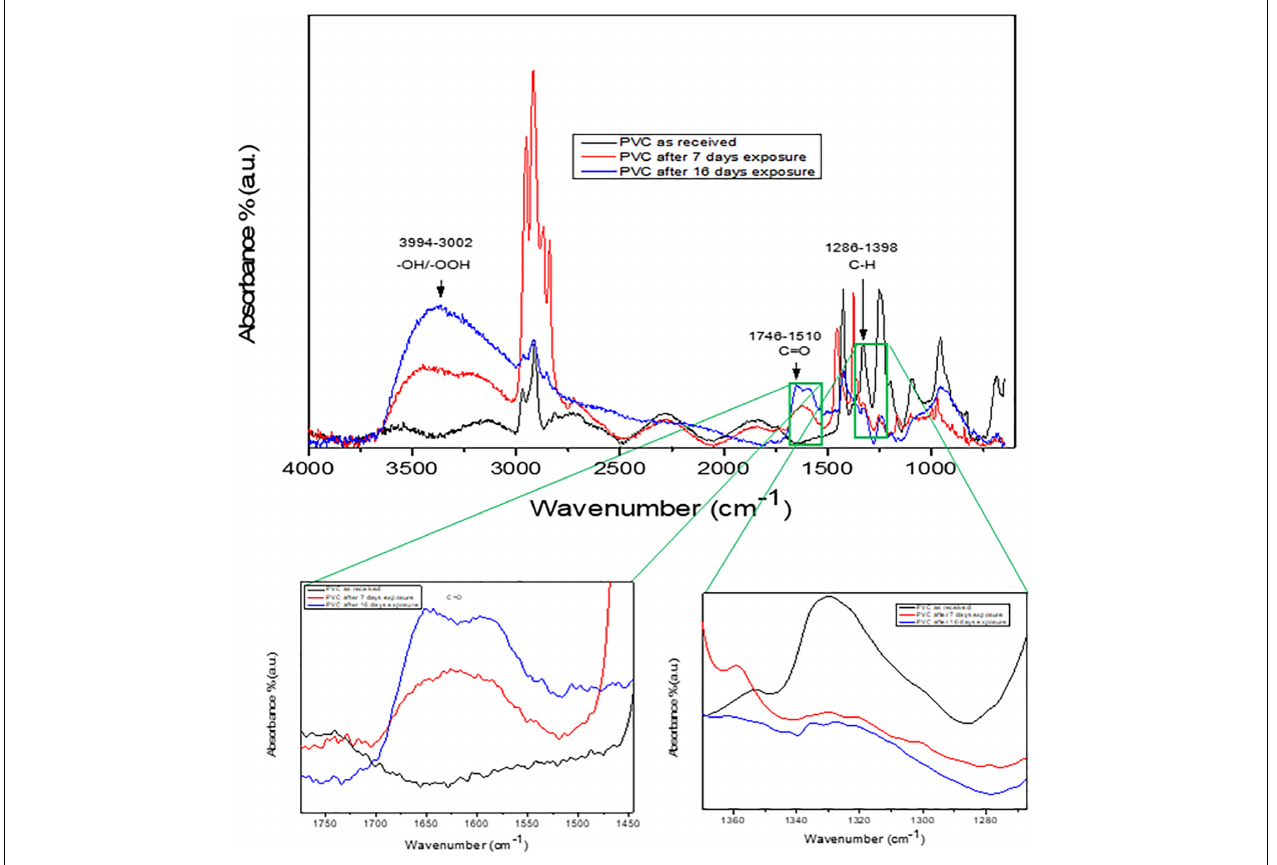
FIGURE 4 | FTIR spectrum of PVC microplastics degradation using Photo-Fenton process. The carbonyl and carboxyl groups are highlighted in the spectra.